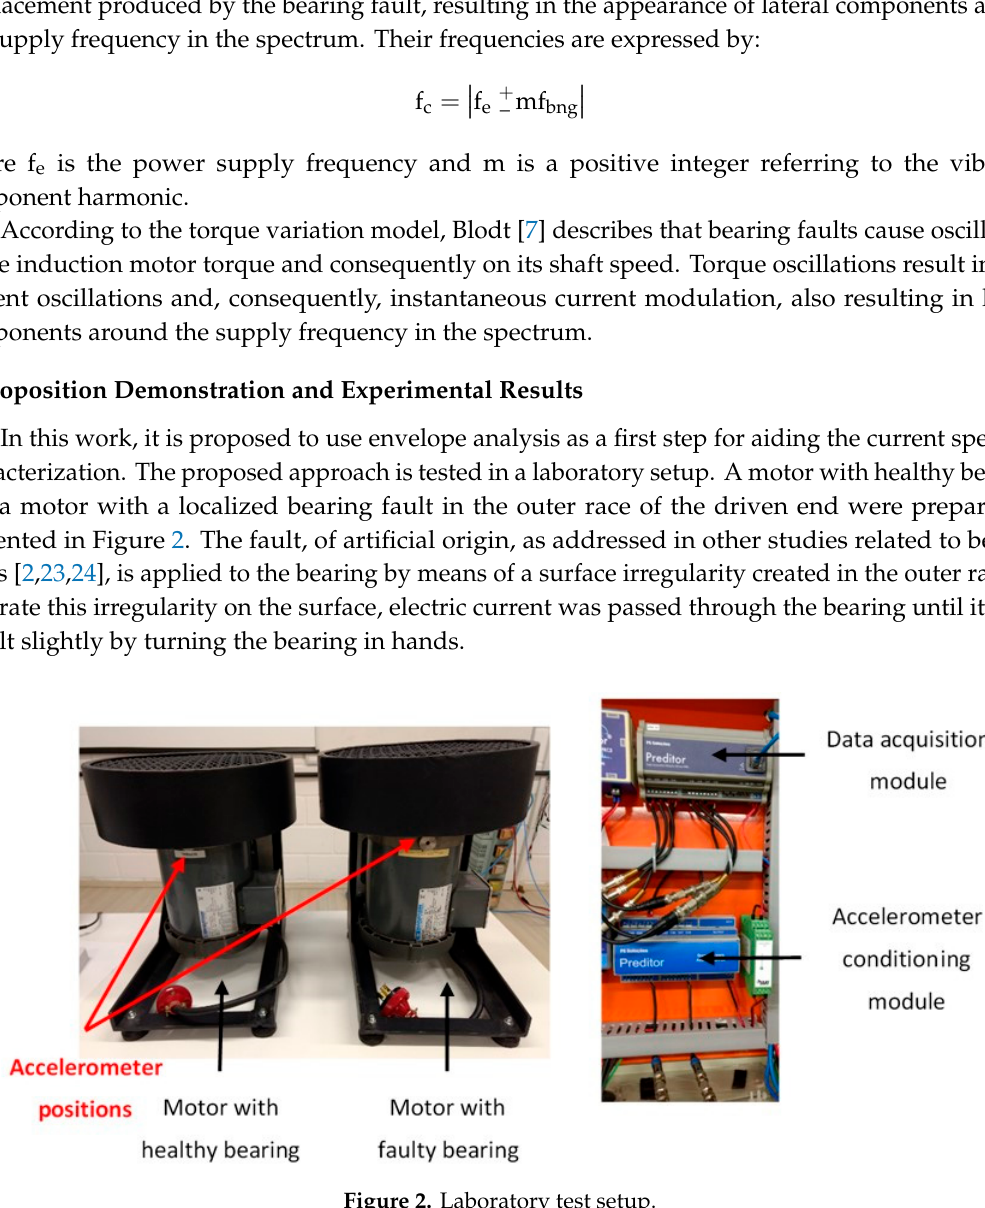
Figure 2. Laboratory test setup.